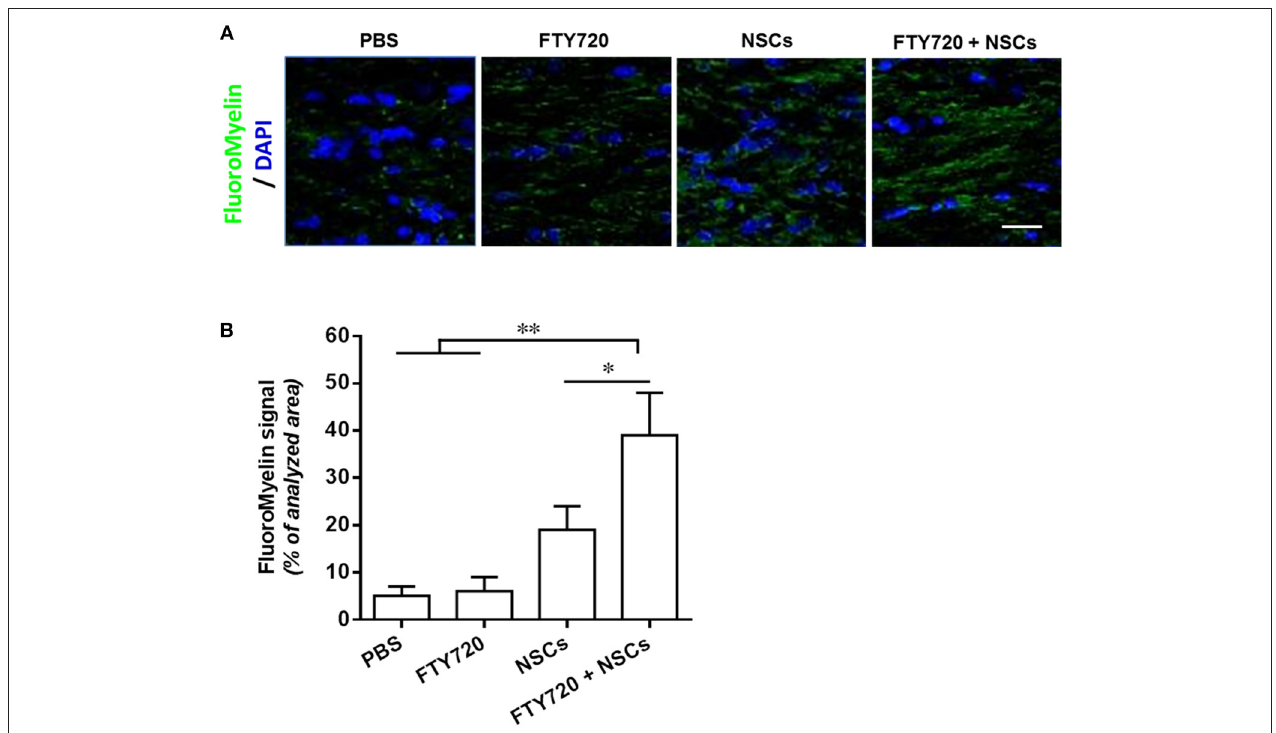
FIGURE 6 | FTY720 in combination with transplanted NSCs efficiently myelinated the shiverer brain. In separate experiments, mice were treated as described in Figure 5 , and brains were harvested at day 90 postnatal for immunostaining. (A) Confocal micrographs showing FluoroMyelin staining in the midline of the corpus callosum of shiverer mice treated with NSCs and/or FTY720. (B) Averaged values (mean ± SEM) of myelin signal density in the midline of the callosal body from treatment groups shown in (A) . * p < 0.05, ** p < 0.01. One-way ANOVA with Tukey’s multiple comparisons test and unpaired Student’s t -test. One representative of 3 independent experiments is